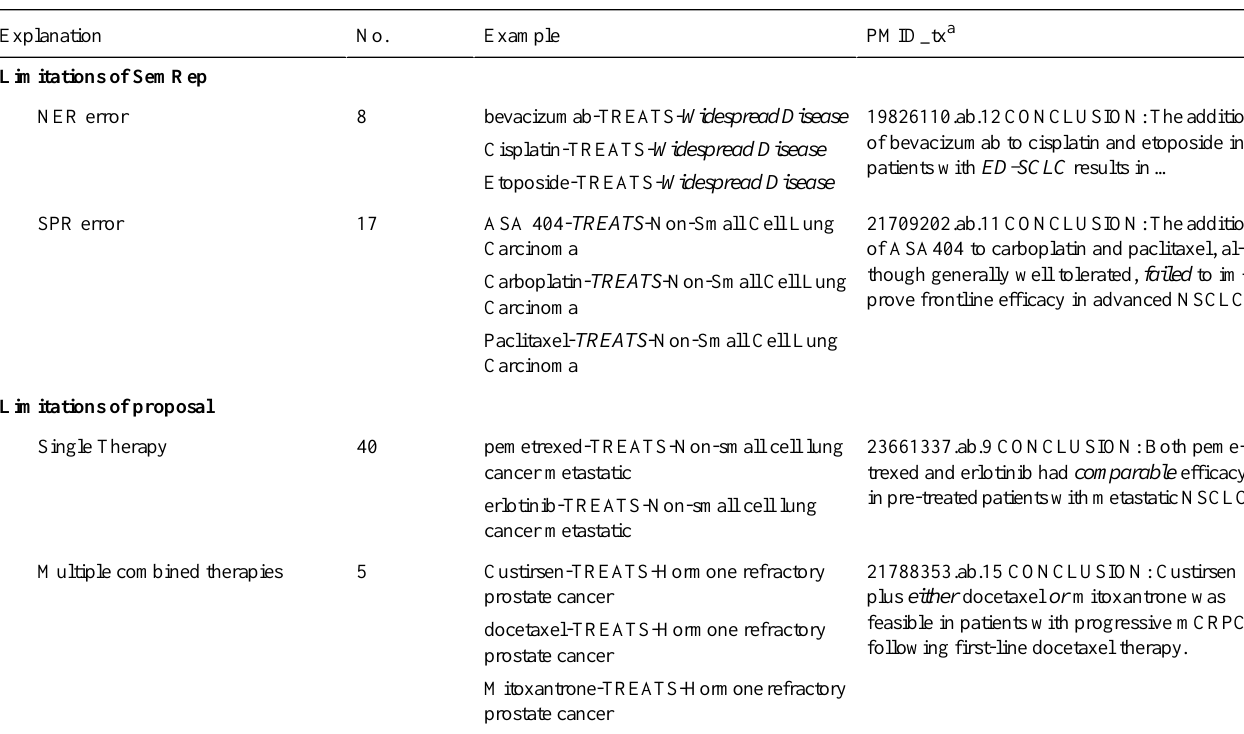
Table 3. Characteristics of inaccurate results from proposed automatic algorithm.